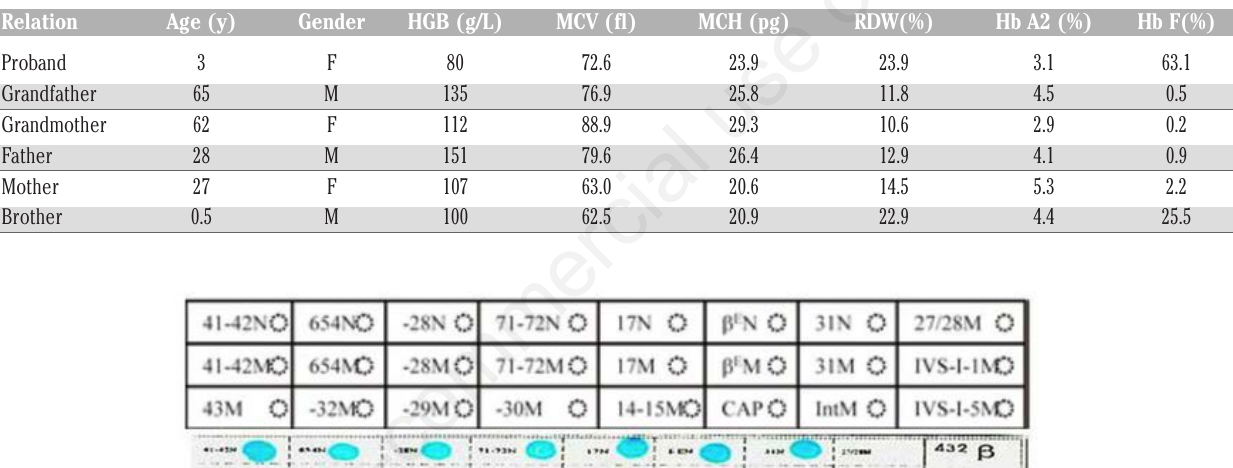
Table 1. Hematological features of all the family members.